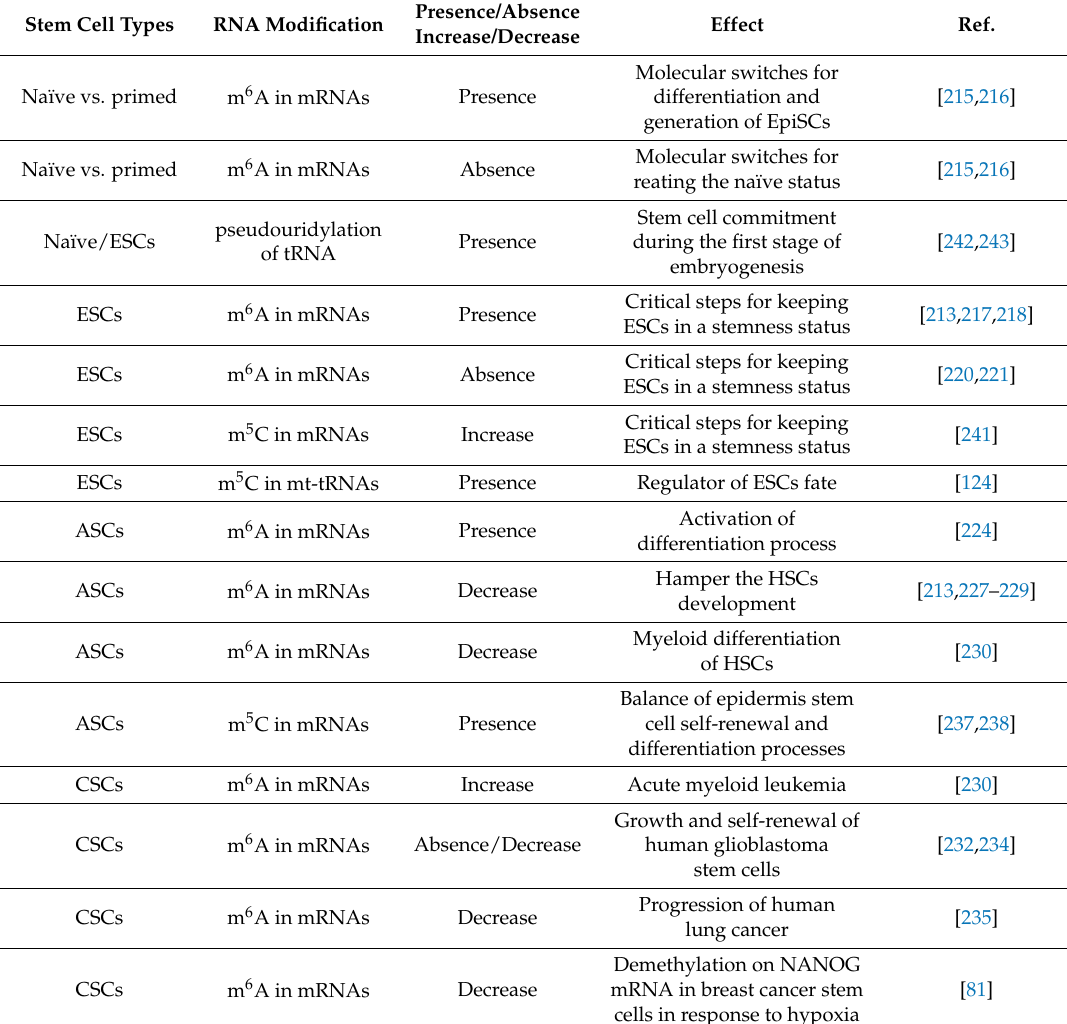
Table 4. Correlation between RNA modifications and stem